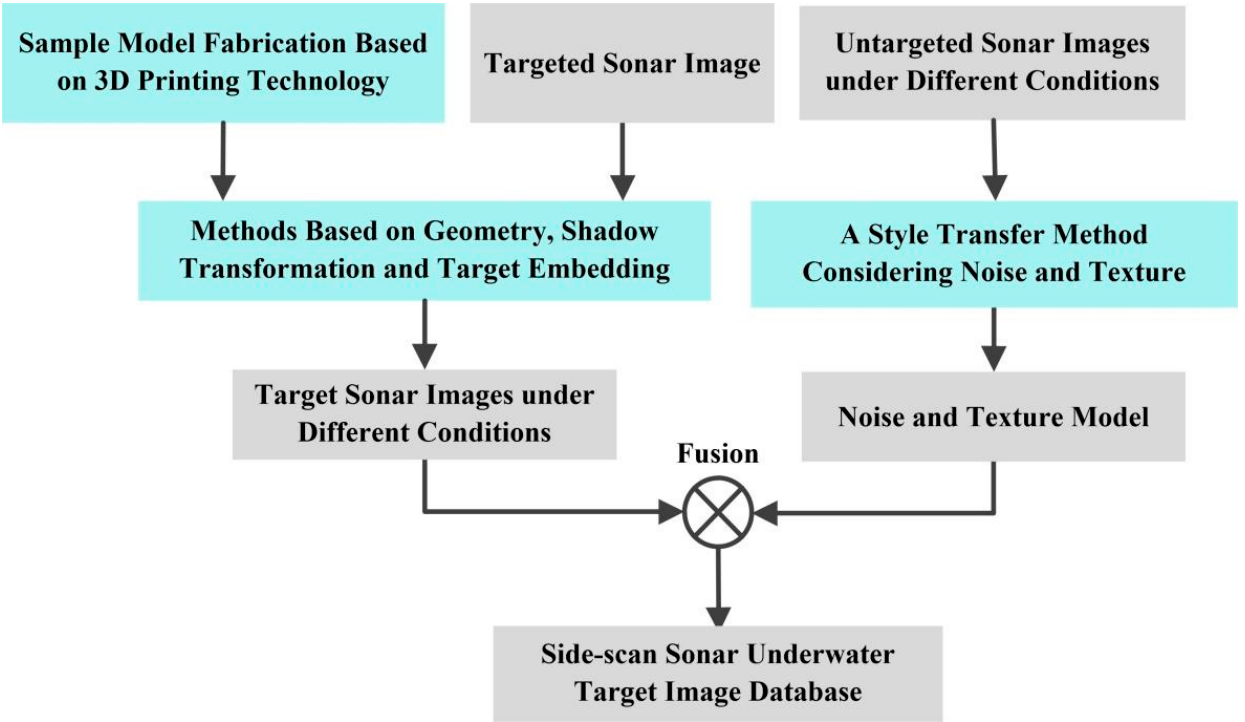
Figure 8. Data augmentation method based on 3D printing.